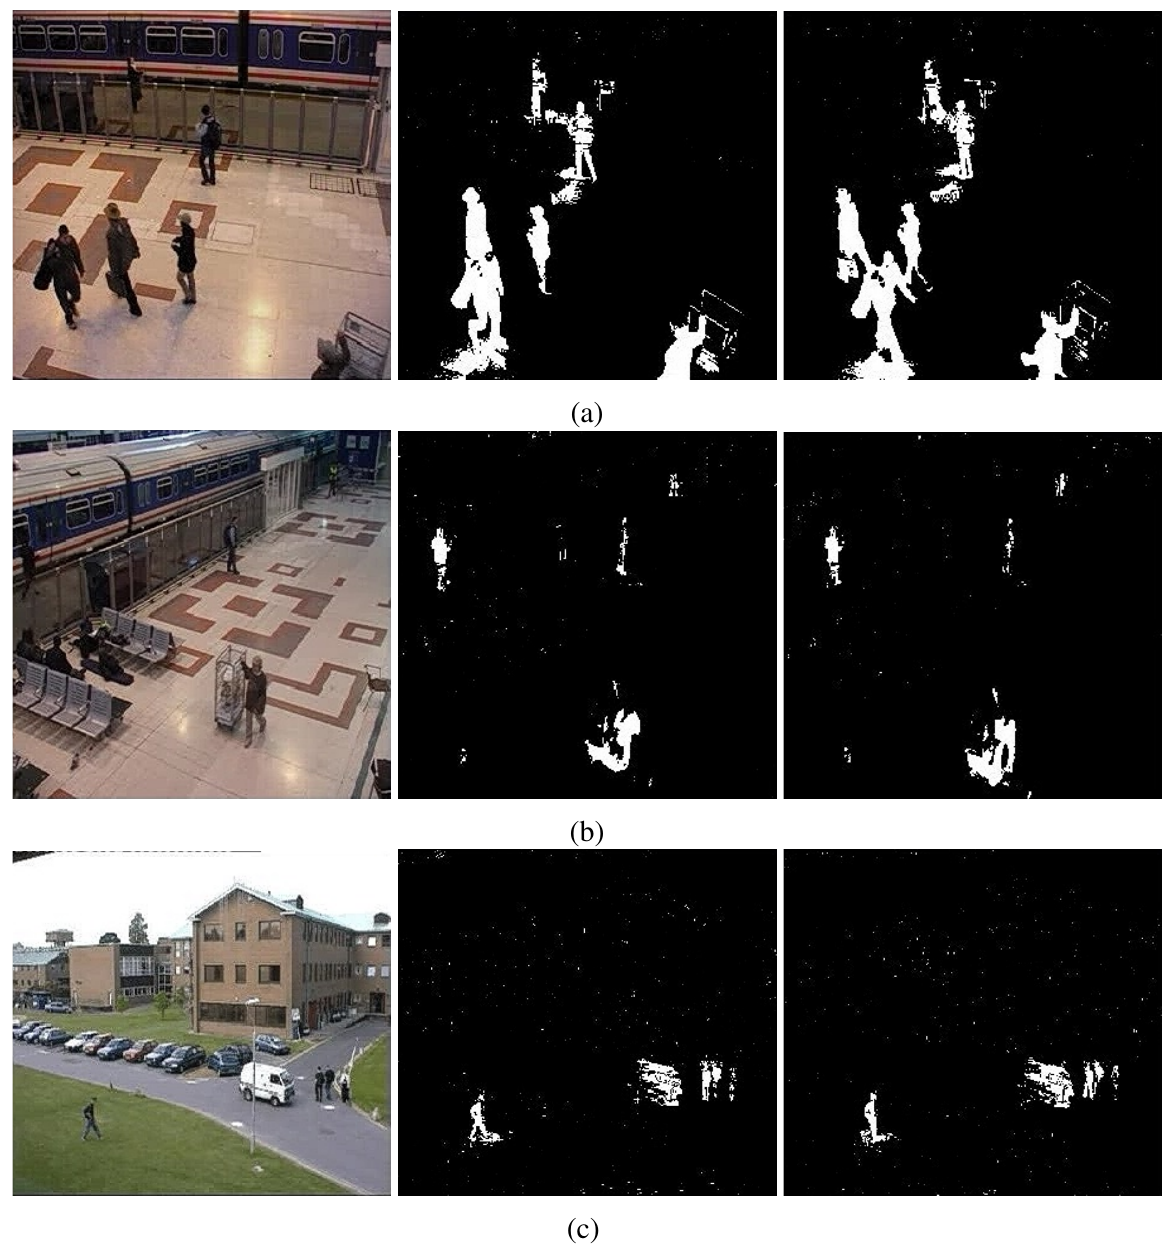
Figure 7. Foreground detection from images sequences of the PETS database [17, 18] using the MOG approach[3]. The sequences in (a) and (b) correspond to cameras monitoring a train stop; the sequence in (c) corresponds to a car parking. The objects detected are not well defined, and in several frames, some objects are discarded (especially in thin object structures). The motion detection is sensitive to shadows and images are pruned with